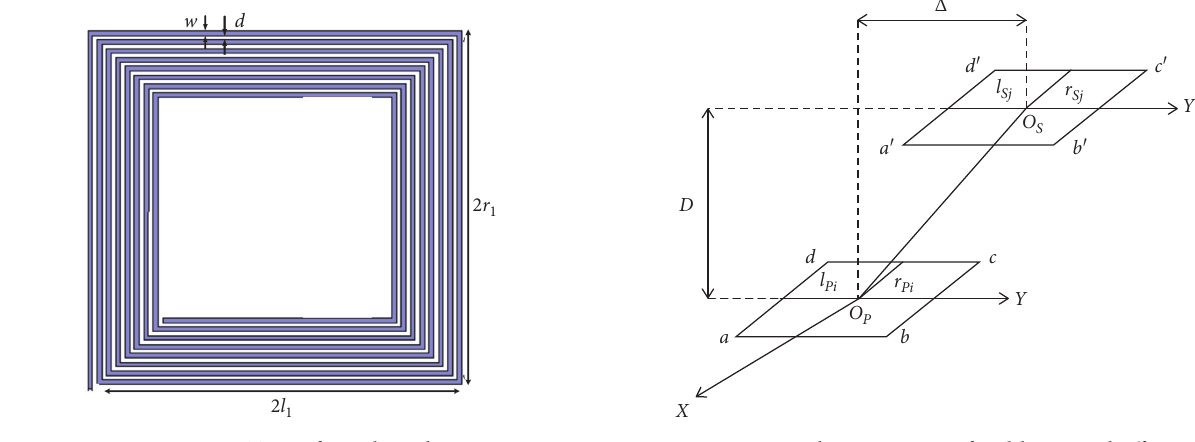
Figure 5: ICPT transfer coil winding. Figure 6: Relative position of coil horizontal